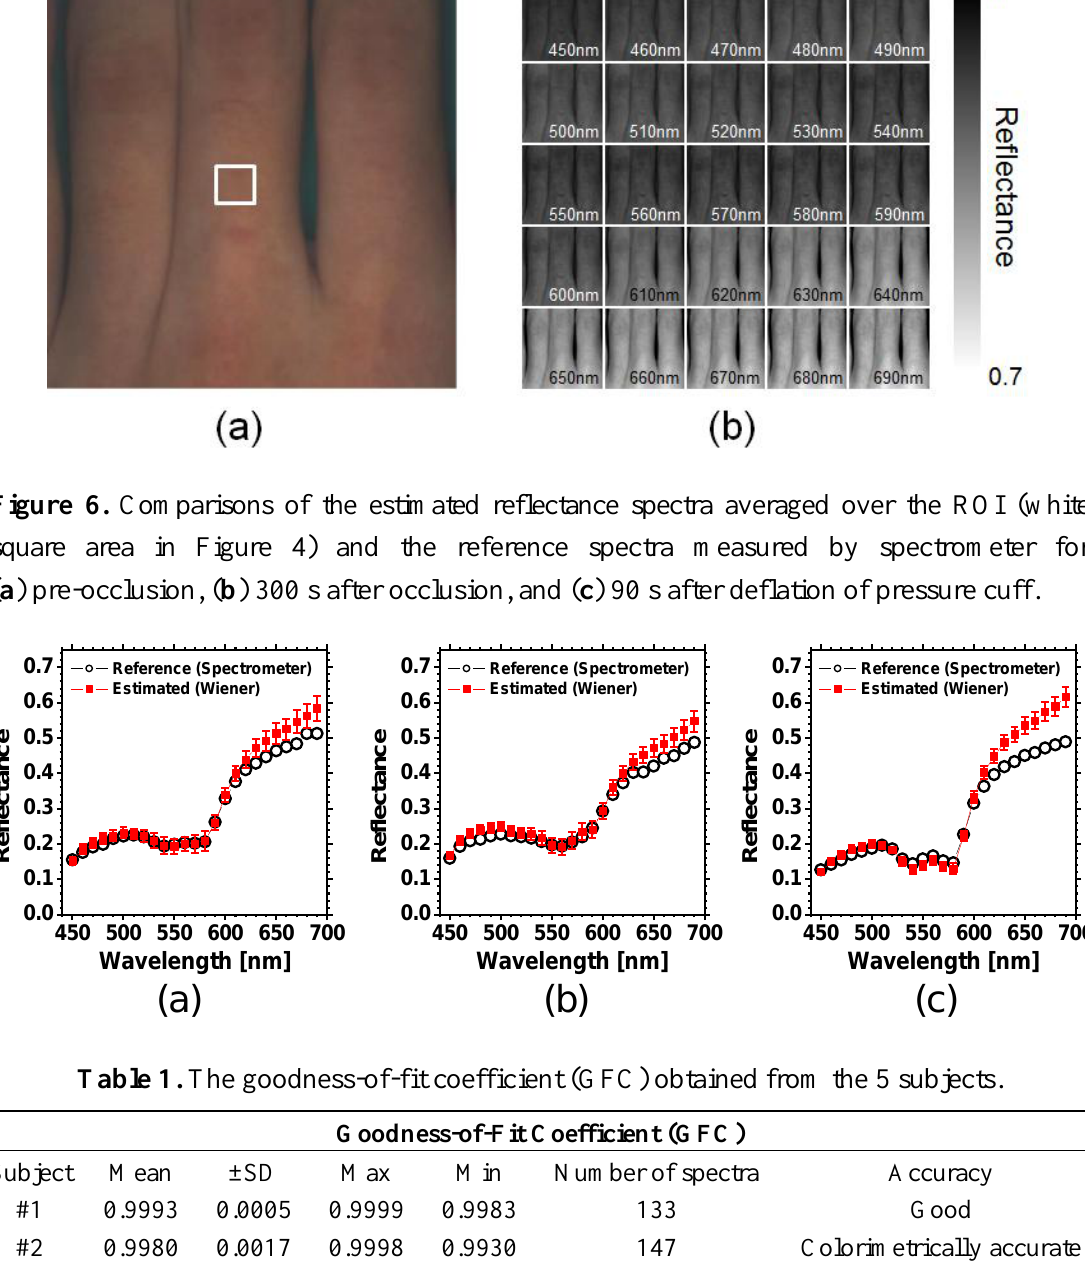
Figure 5. In vivo results obtained from human fingers under the normal condition for ( a ) raw RGB image and ( b ) the estimated images of spectral diffuse reflectance by the Wiener estimation.